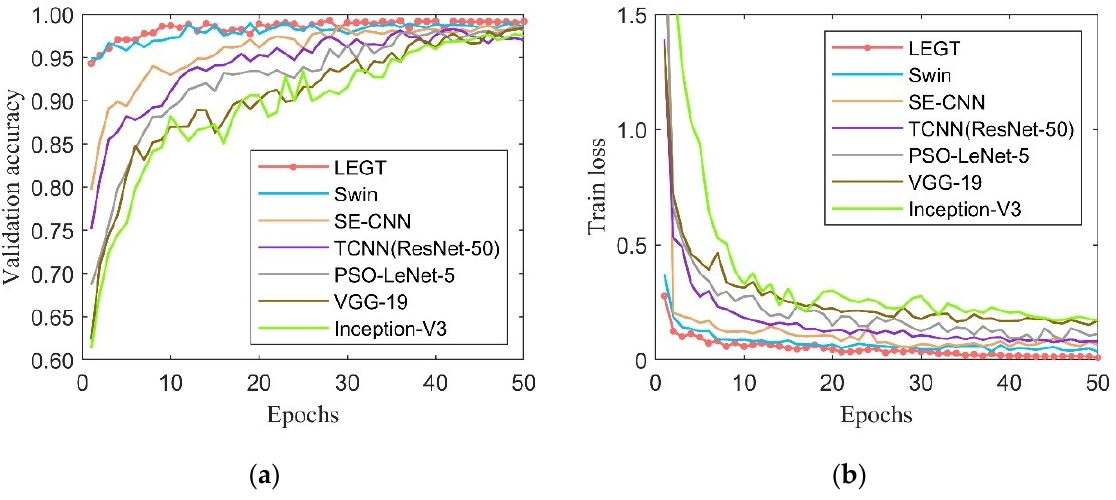
Figure 23. The training process among different models: ( a ) validation accuracy curves; ( b ) training loss curves.